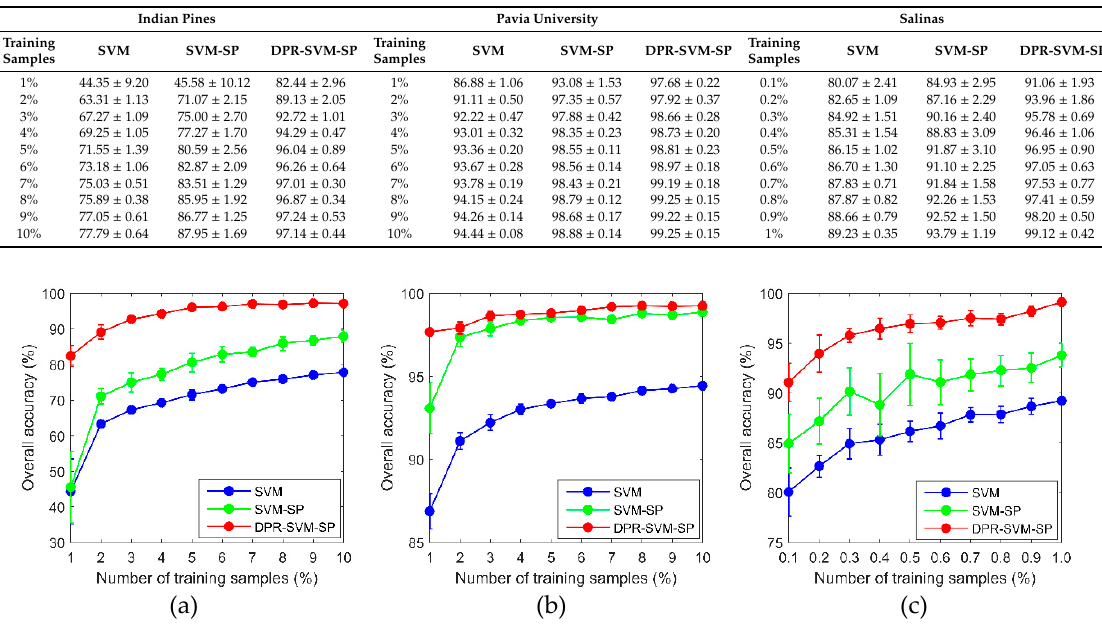
Table 7. The variation of average classification accuracy (OA in percent) of three datasets with the increase of the number of training samples.